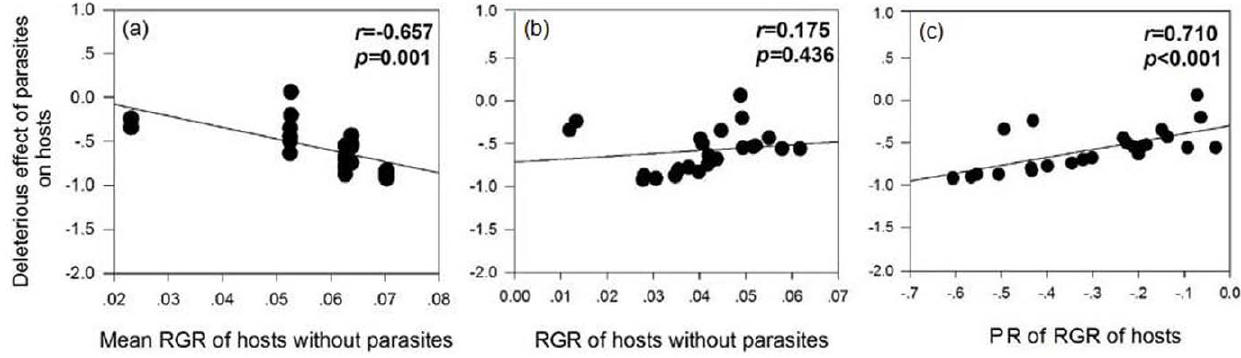
Figure 3. Correlation between the deleterious effect of parasites on hosts and the relative growth rate (RGR) of host with parasite (a) and without parasite (b), parasitism response of RGR of hosts (c). Pearson correlation coefficient ( r ) and p -values are given and values in bold are statistically significant at p , 0.05.